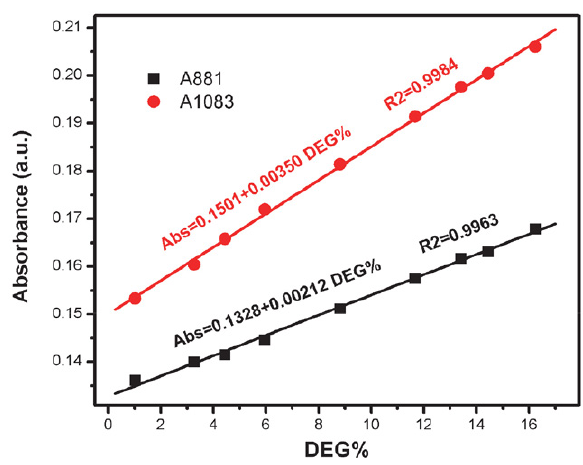
Figure 3. The intensity of the IR bands at 881 cm –1 and 1083 cm –1 versus DEG% in spiked Hederal samples.